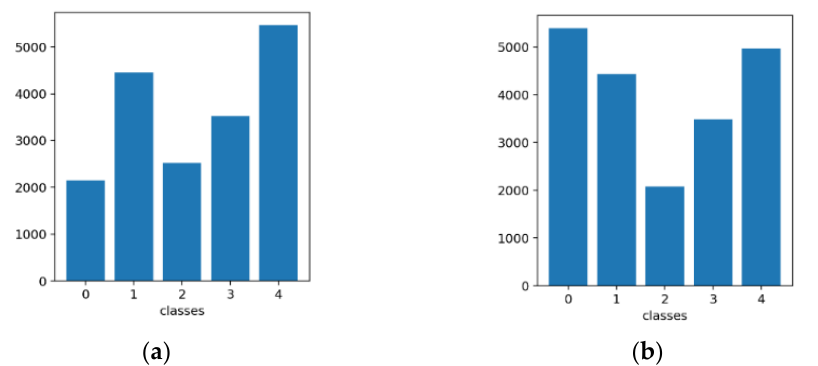
Figure 12. Images per class distribution. The classes are: 0 = person without any handicap; 1 = person using crutches; 2 = person in a wheelchair; 3 = person in a wheelchair that is pushed by another person; 4 = person using a walking frame. ( a ) Hospital1 ( b ) Hospital2.